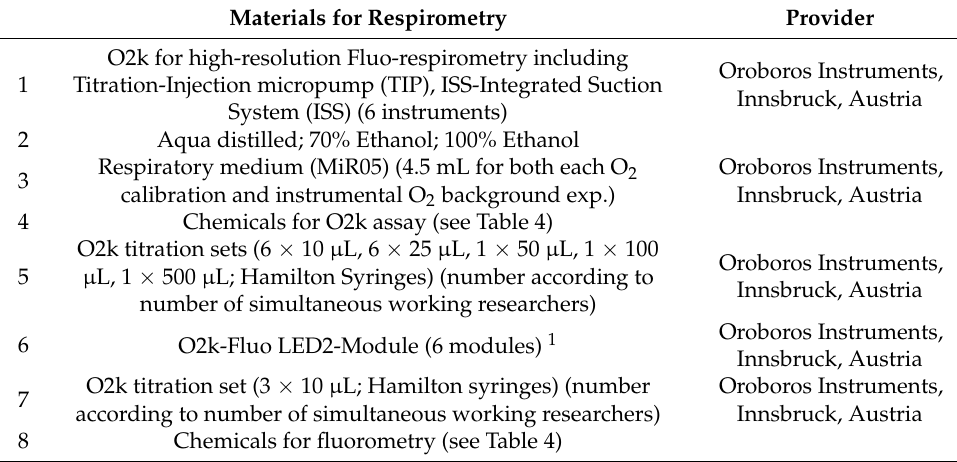
Table 2. Materials for O2k FluoRespirometry